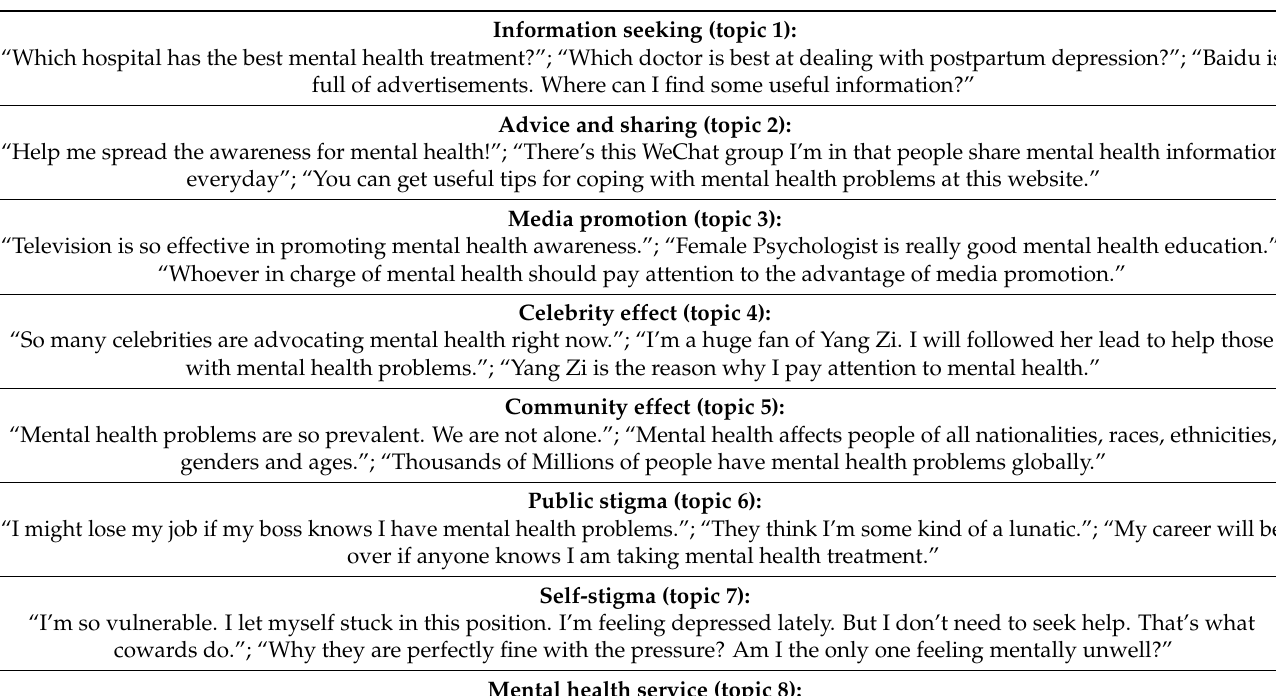
Table 2. Most representative Weibo texts and topic label